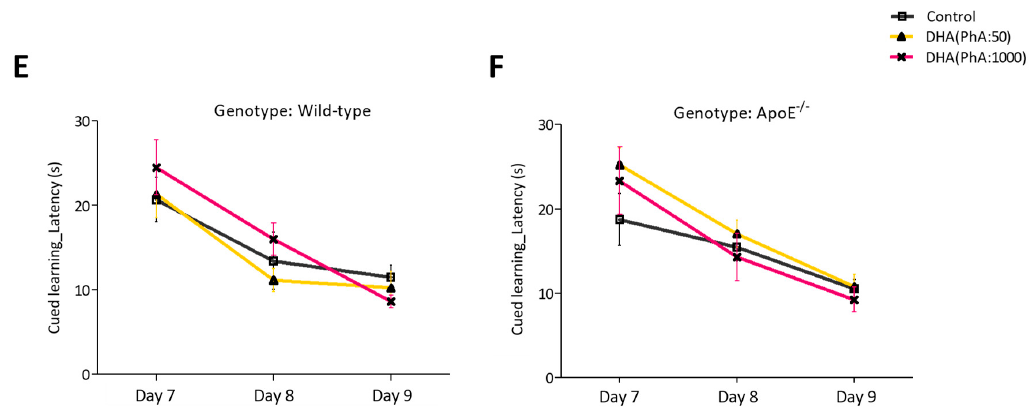
Figure 3. Effects of DHA (PhA:50) and DHA (PhA:1000) on relative protein expression of ( A ) amyloid precursor protein (APP) and ( B ) amyloid beta (Aß) in hippocampus of ApoE − / − and wild-type mice. Data show mean ± SEM. * p < 0.05 compared to control wild-type mice; # p < 0.05 compared to control ApoE − / − mice; $ p < 0.05 compared between DHA (PhA:50) and DHA (PhA:1000) in ApoE − / − mice. ( n = 8 or 9).